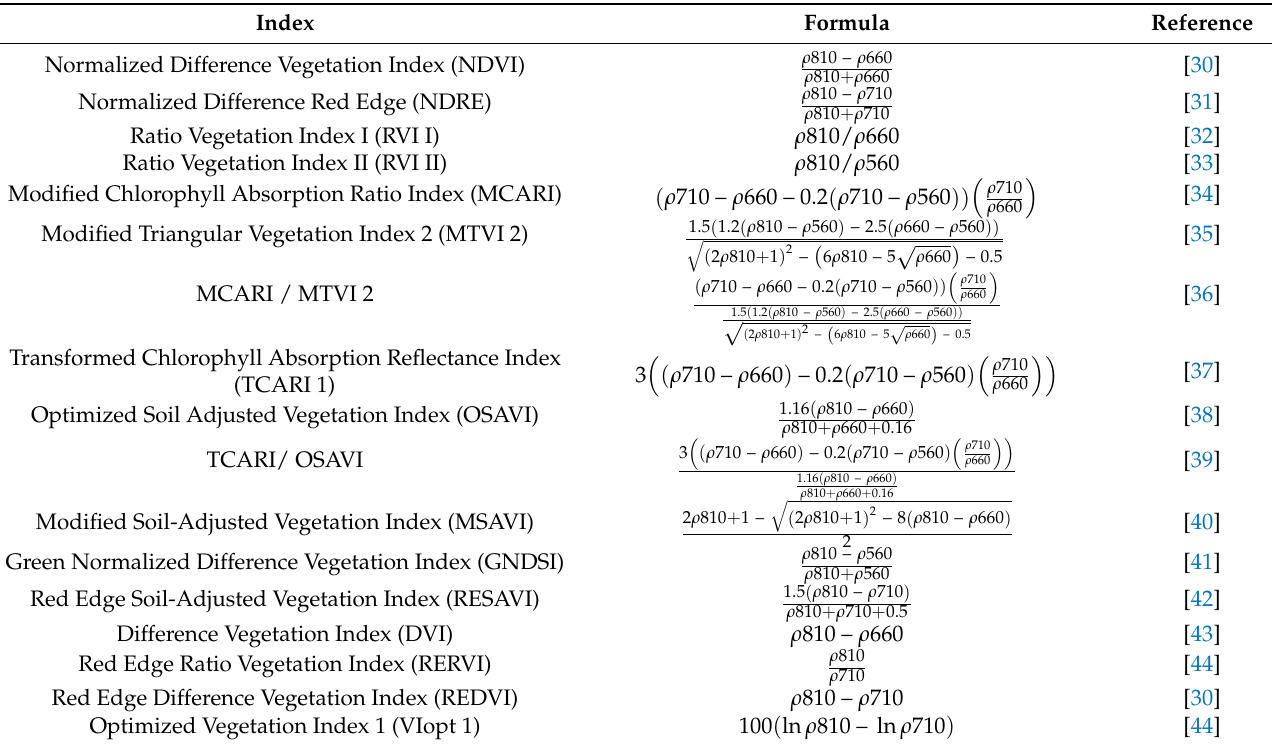
Table 1. Summary of the vegetation indices